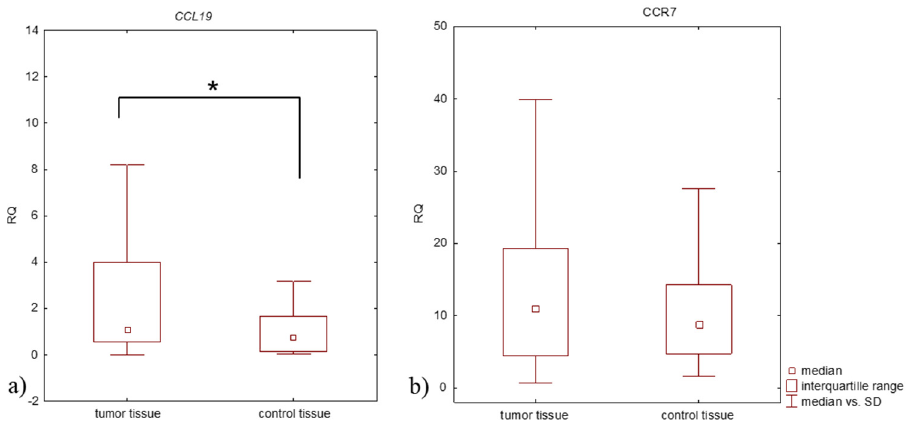
Figure 1. Box plot showing differences in RQ medians for ( a ) CCL19 , ( b ) CCR7 in tumor and control tissue in patients with NSCLC (Mann-Whitney U-test); * p <